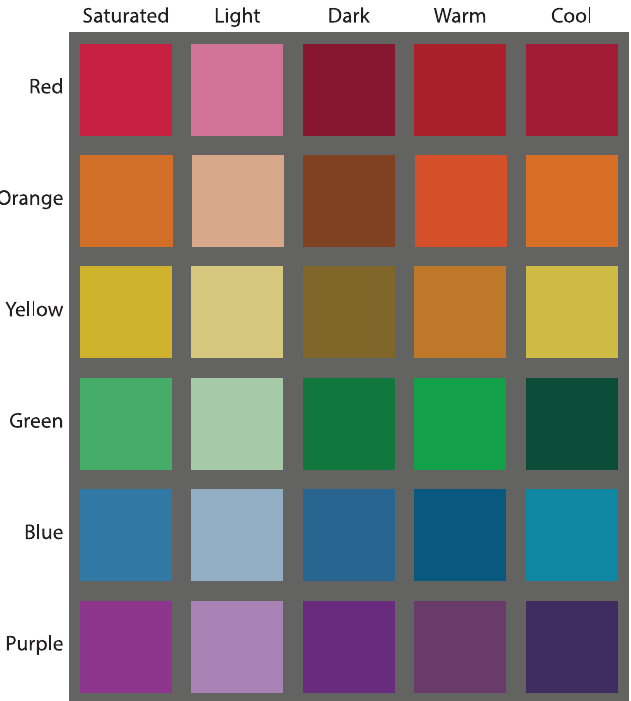
Figure 1. The 30-color palette used for the multi-sensory color code experimentation. The six hues on the left of the figure are described through the saturated, light, dark, warm, and cool dimensions. The saturated, light, and dark dimension are based on the BCP-37